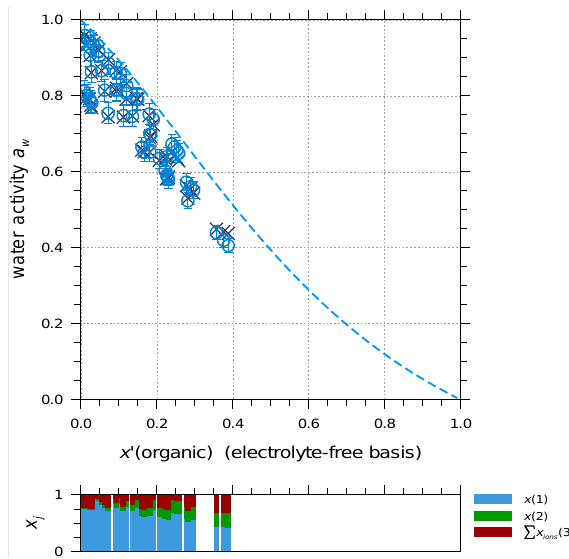
Fig. 3. Water activities in the ternary system water (1)+malonic acid (2)+ ( NH 4 ) 2 SO 4 (3) at 298K. Experimental bulk a w data ( ) by Salcedo (2006) and corresponding calculated values ( ) at var- ious mixture compositions, as shown in the bar graphs. The error bars represent the model a w -sensitivity to a composition variation by x tol = 0 . 01. The dashed curve shows the calculated water activ- ity of the salt-free solvent